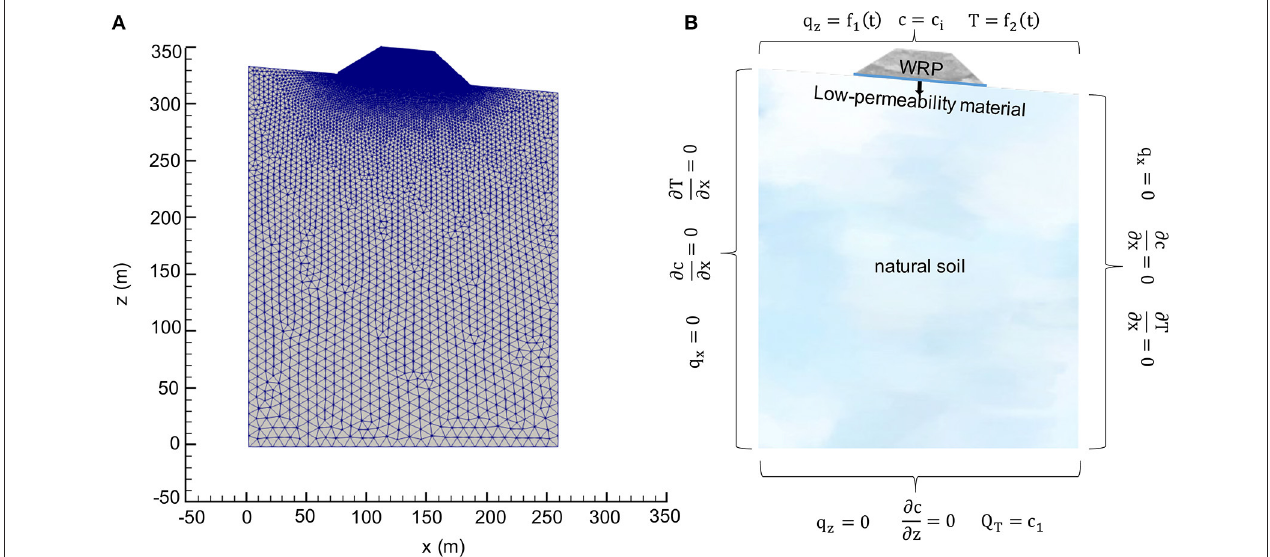
FIGURE 5 | (A) Geometry and discretization of 2D model, (B) Corresponding boundary conditions.